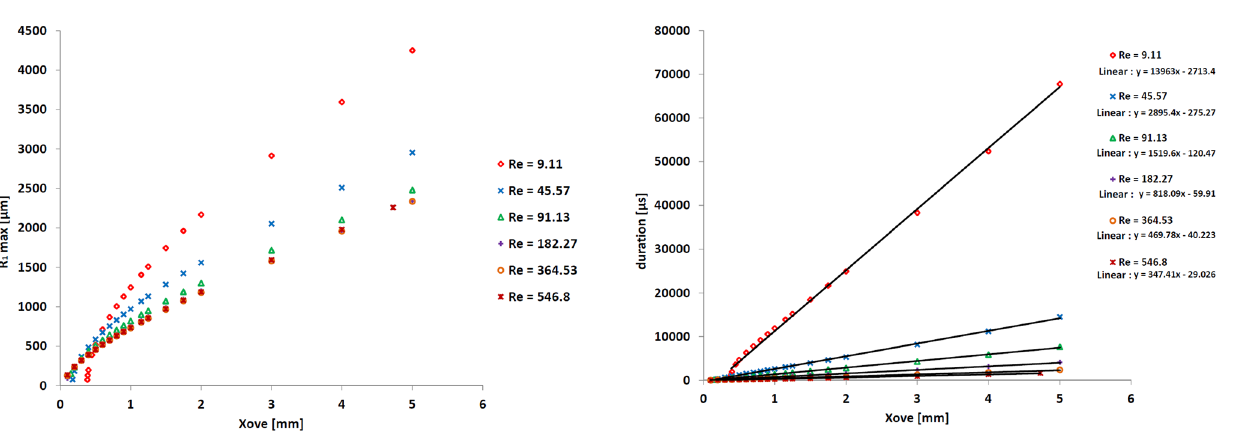
Fig. 9 Maximum radius R Reynolds number Re H